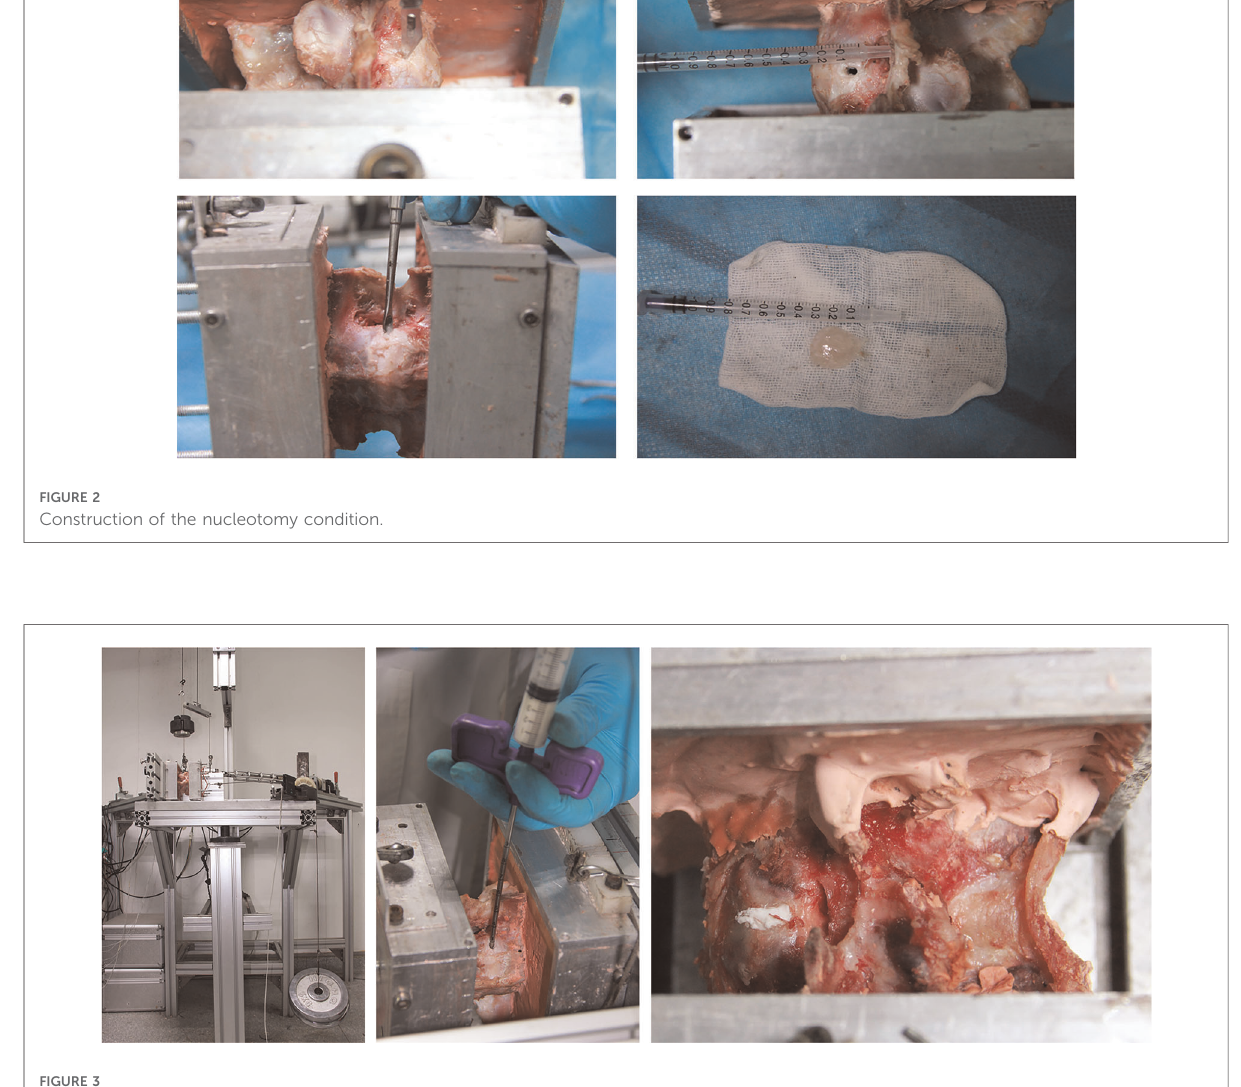
FIGURE 3 Construction of the discoplasty